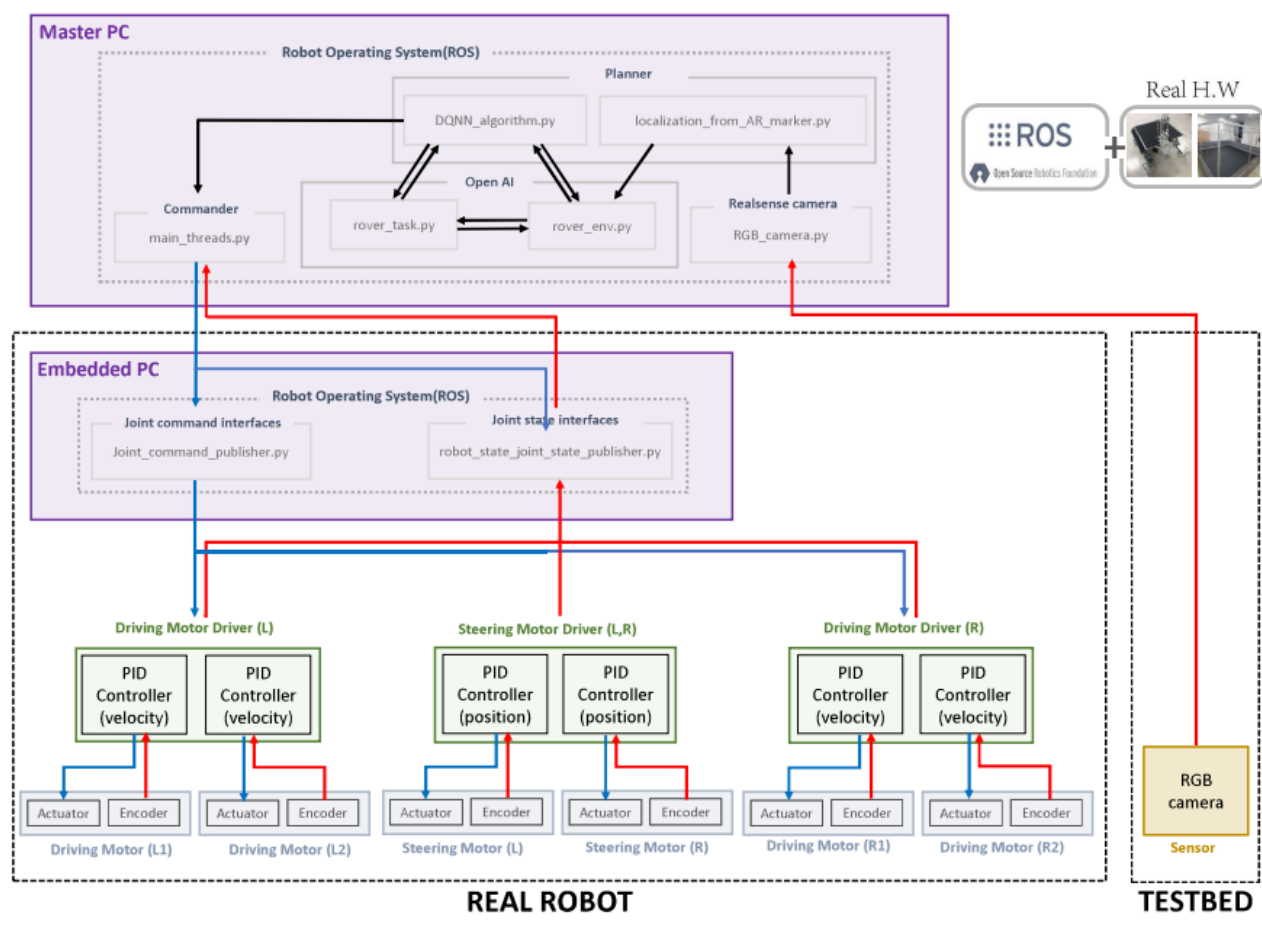
Figure 17. A schematic of the control system of the 4-wheeled 2-steering lunar rover. ( a ) Simulated robot system implemented based on the actual hardware interface. ( b ) Robot system implemented in a simulation